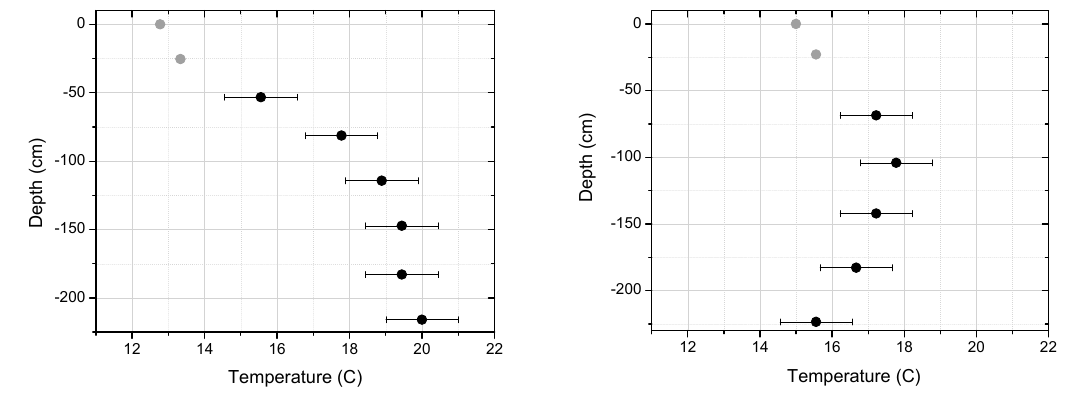
Figure 7. Temperature profiles below the water surface from two dips at the Rawhide Energy Station ( Left : dip 1, Right : dip 2).